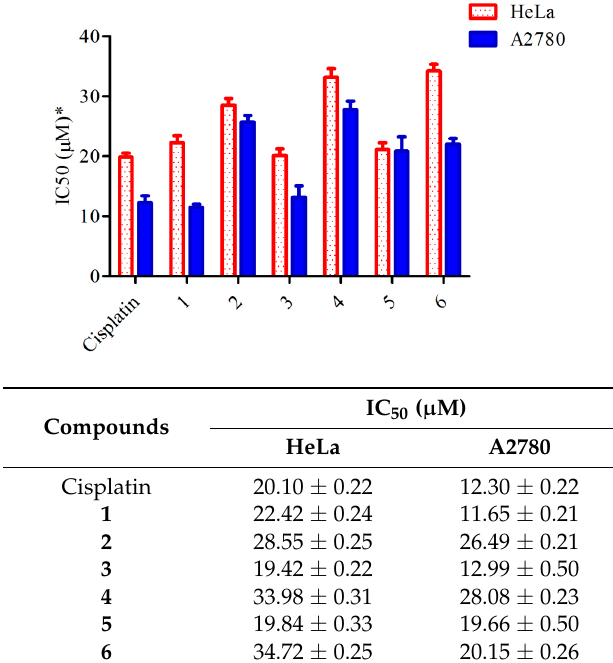
Figure 1. Cytotoxic activity of in vitro of Compounds 1 – 6 against HeLa and A2780 tumor cells. * Data are reported as IC 50 values determined by MTT assay after 24 h of continuous exposure to each compound. The values were calculated using sigmoidal dose-response relationship. The data represents mean values ± SEM (standard error of mean) of at least three independent experiments.